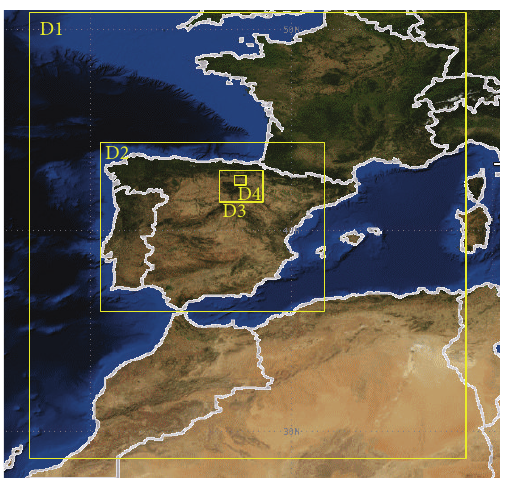
Figure 1: MM5 base-case model